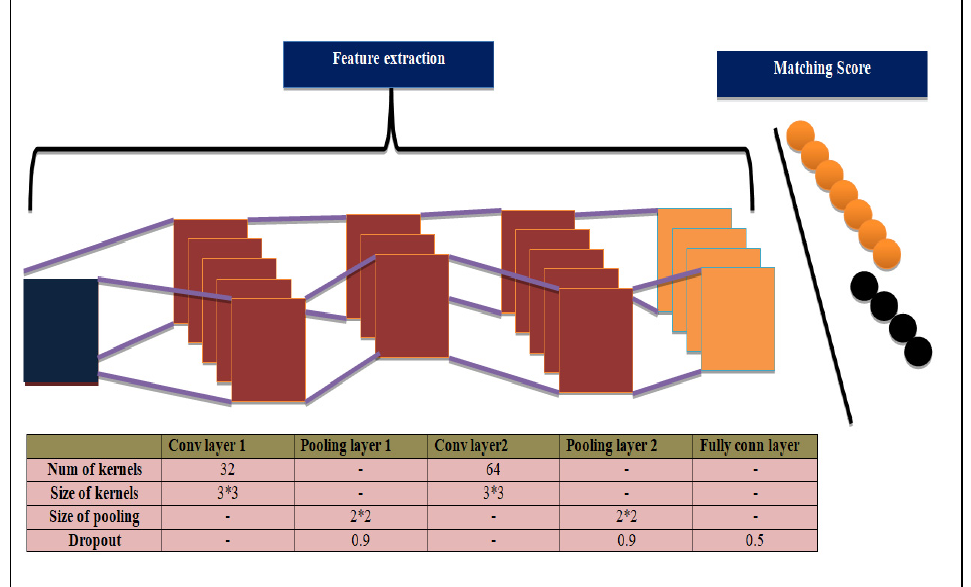
Figure 3. The 2D CNN architecture.